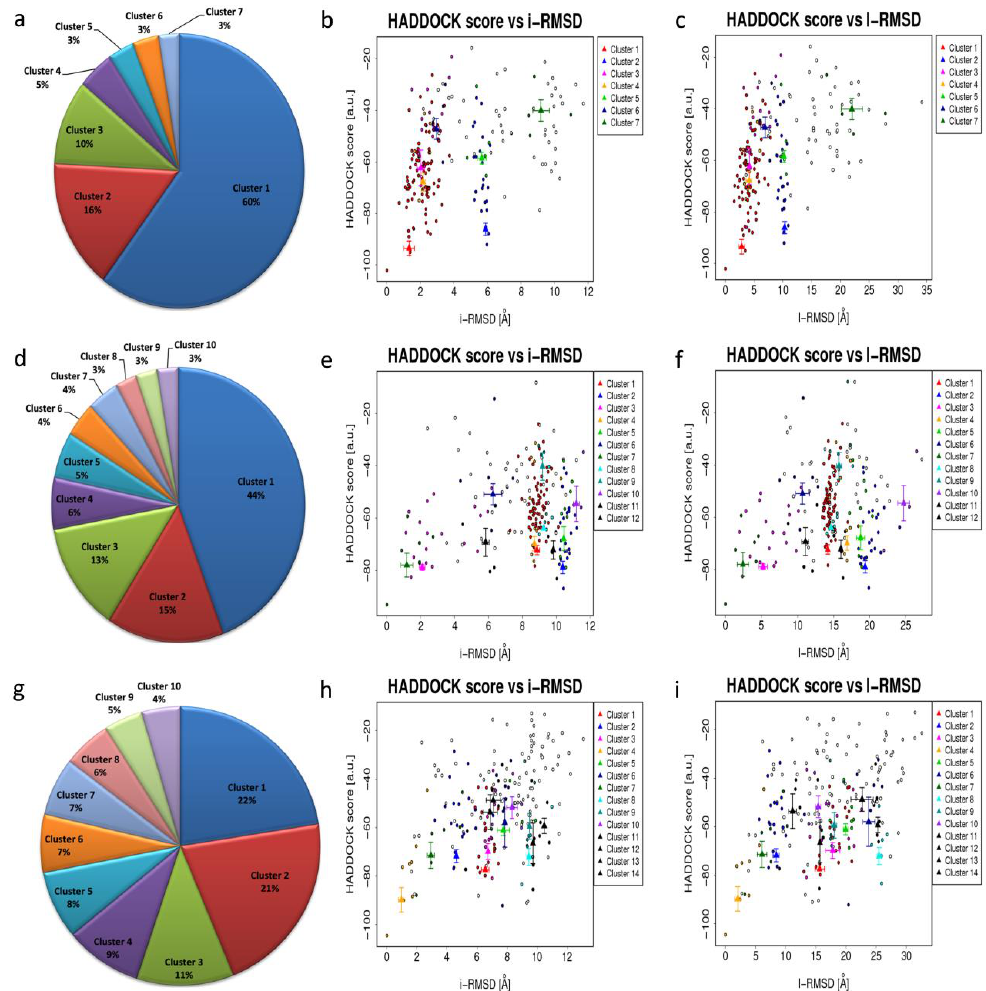
Figure 5. Distribution of HADDOCK clusters estimated for the ( a ) Type I docked complex; ( d ) Type II docked complex and ( g ) Type III docked complex; ( b,c ) HADDOCK scores versus i-RMSD plot and HADDOCK scores versus l-RMSD plot for Type I WRKY – DNA complex; ( e,f ) HADDOCK scores versus i-RMSD plot and HADDOCK scores versus l-RMSD plot for Type II WRKY – DNA complex and ( h,i ) Type III WRKY – DNA complex plot for HADDOCK score versus i-rmsd and l-rmsd.